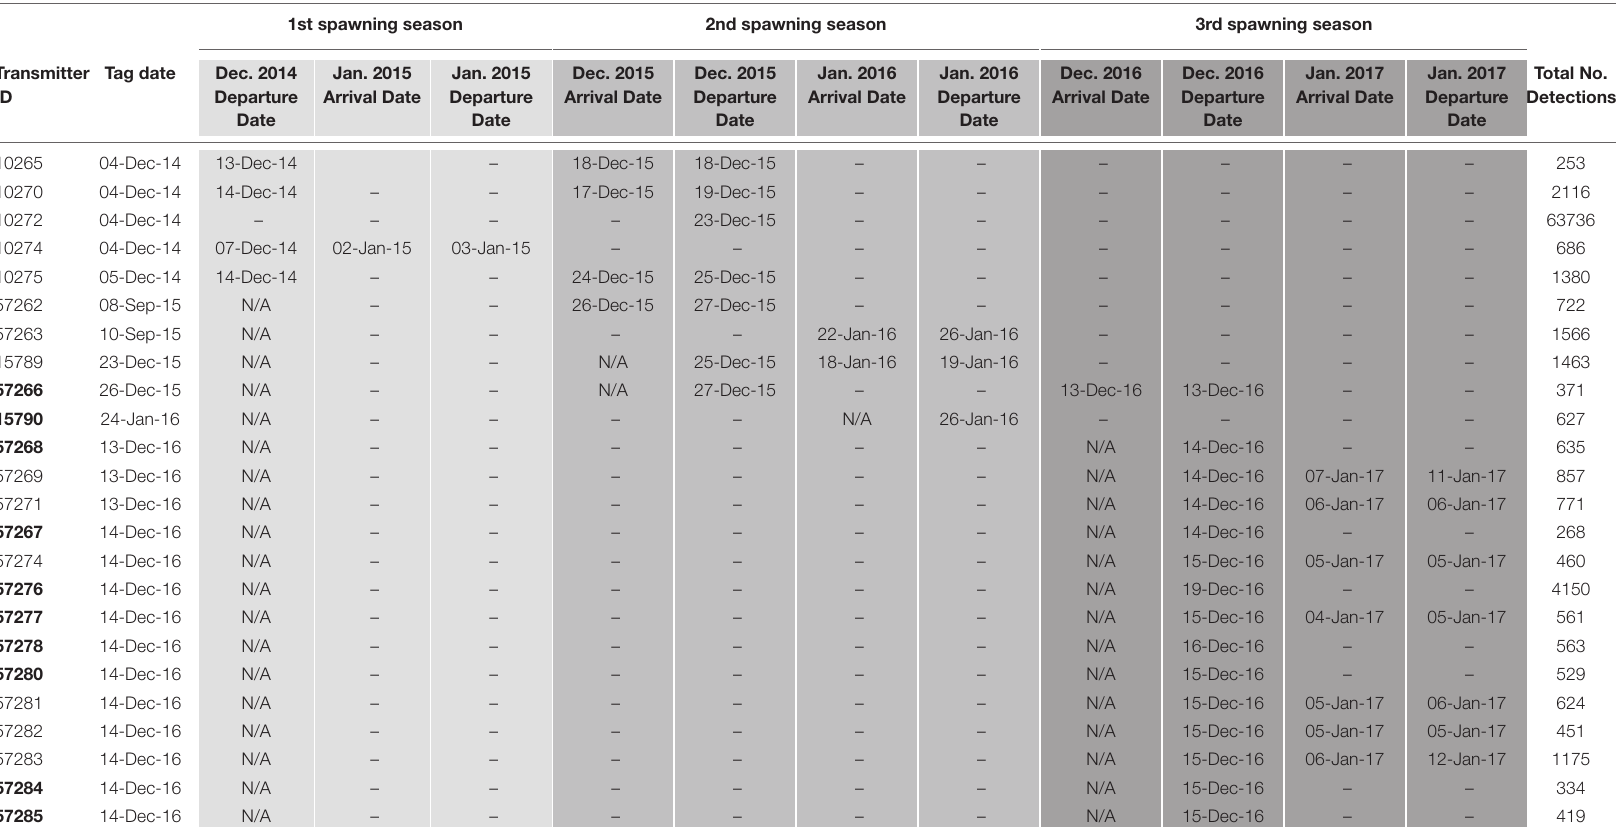
TABLE 4 | Details of acoustic telemetry data including transmitter identification (ID), tag date, detection information [i.e., dates, times, total number of detections across spawning seasons (shaded in progressively darker gray colors)] for Nassau grouper recorded on receivers in the Exuma